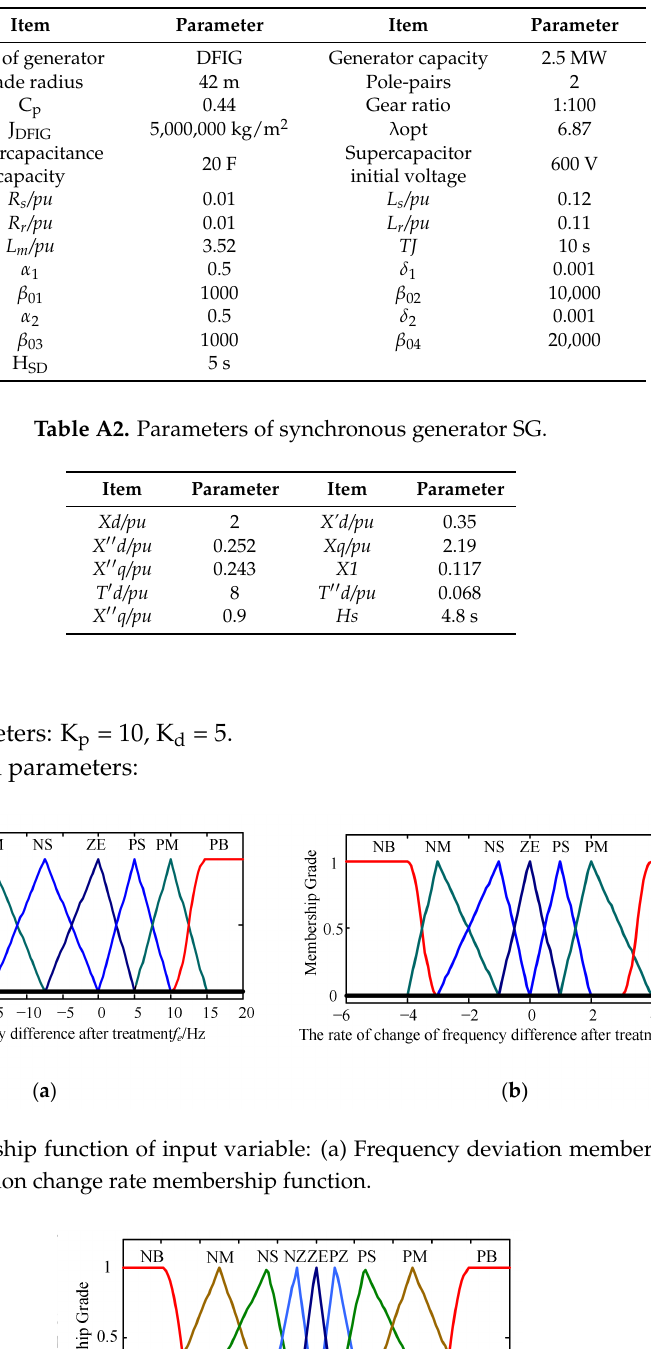
Table A1. The electrical parameters of SCESS-DFIG.